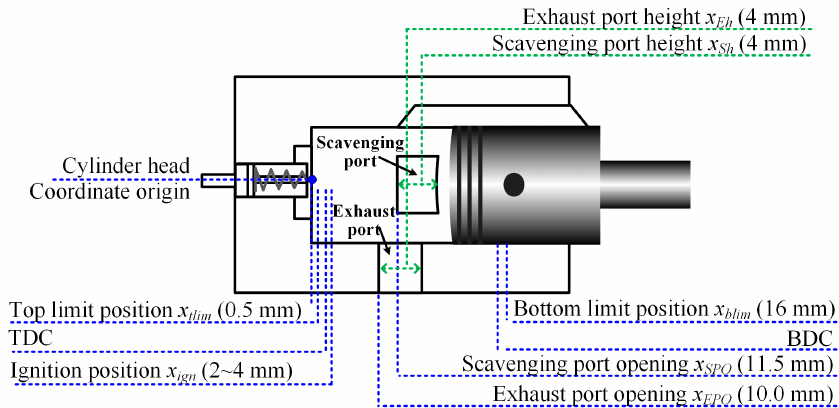
Figure 3. Configuration of the piston coordinates.